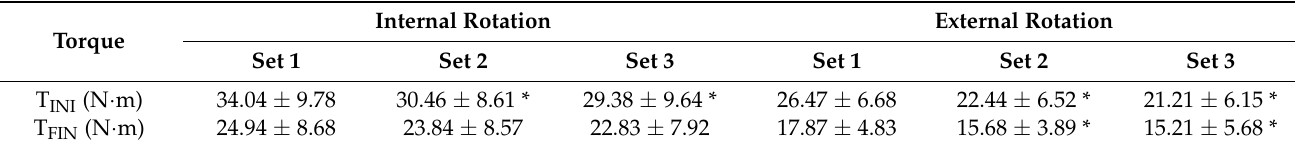
Table 1. Torque output for the first three and last three concentric contractions for each set of 32 maximum internal and external rotations. Internal Rotation External Rotation Torque